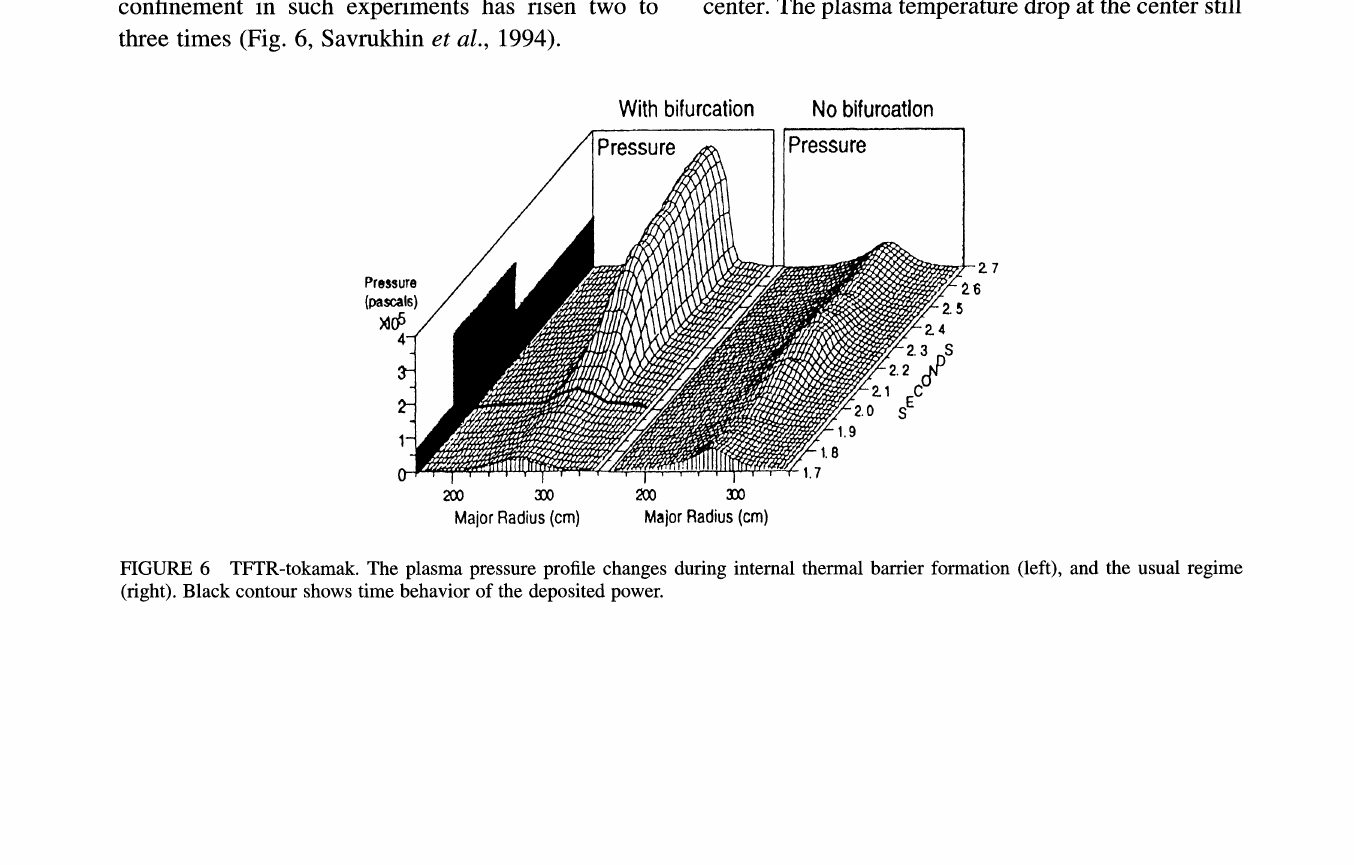
FIGURE 6 TFTR-tokamak. The plasma pressure profile changes during internal thermal barrier formation (left), and the usual regime (right). Black contour shows time behavior of the deposited